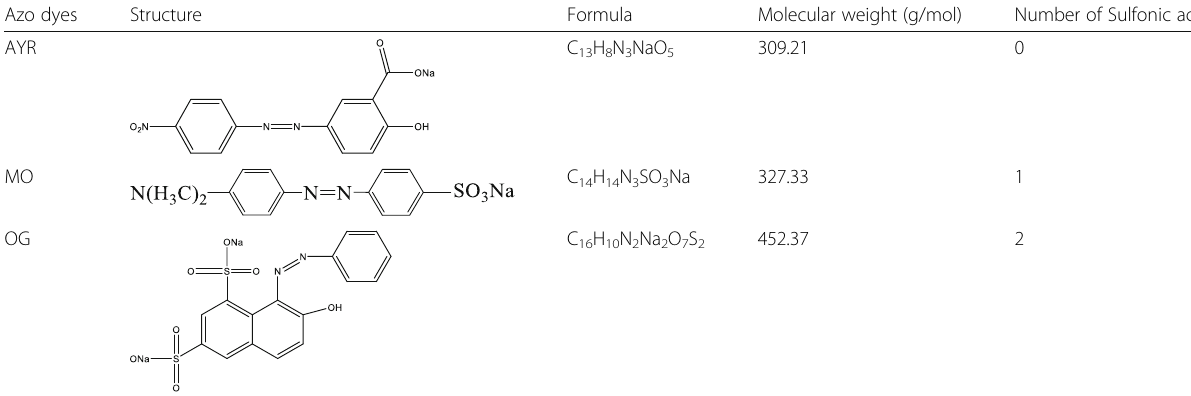
Table 1 Selected properties of azo dyes Azo dyes